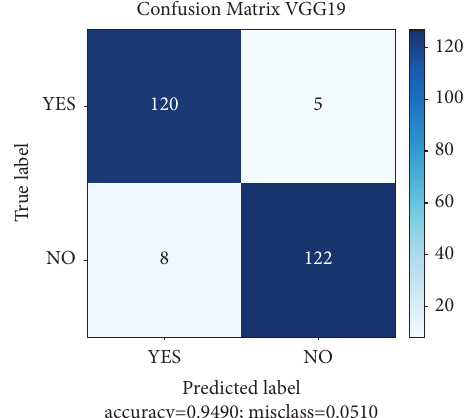
Figure 25: Accuracy evaluation matrix of VGG19 network ar- chitecture using ADAS optimization algorithm via